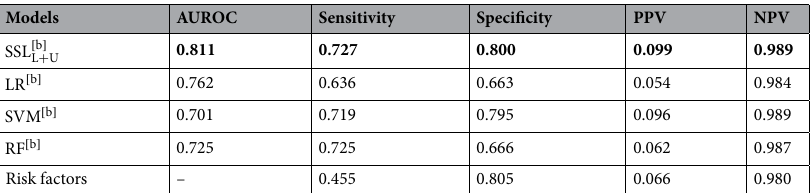
Table 4. Performance comparison in test set. Risk factors: conventional risk factors recommended by American College of Obstetricians and Gynecologists. AUROC area under the ROC curve, PPV positive predicted value, NPV negative predicted value; [a]: models with variables from clinical guidelines, [b] models with selected important variables, and [c] models with all routine variables. The performances of the best model are in